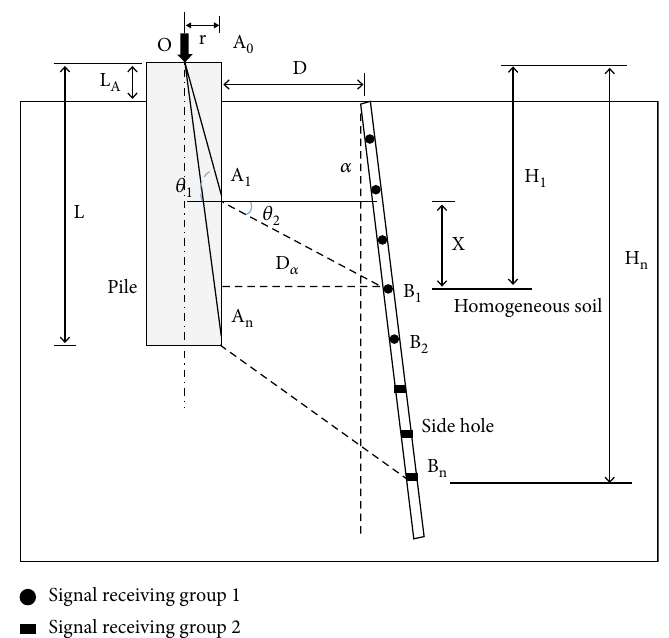
Figure 3: Schematic diagram of the stress wave transmission